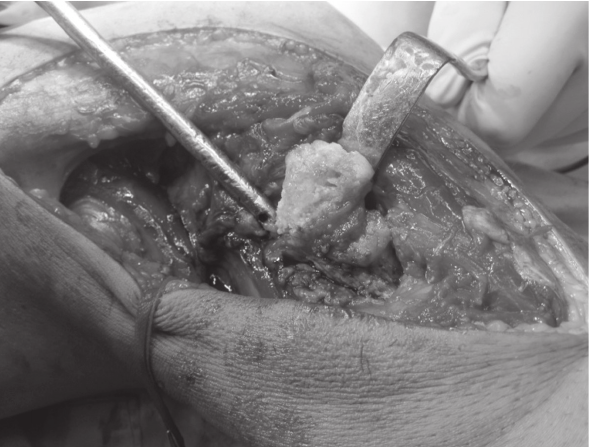
Figure 3.Intraoperative photograph of necrotic fibular